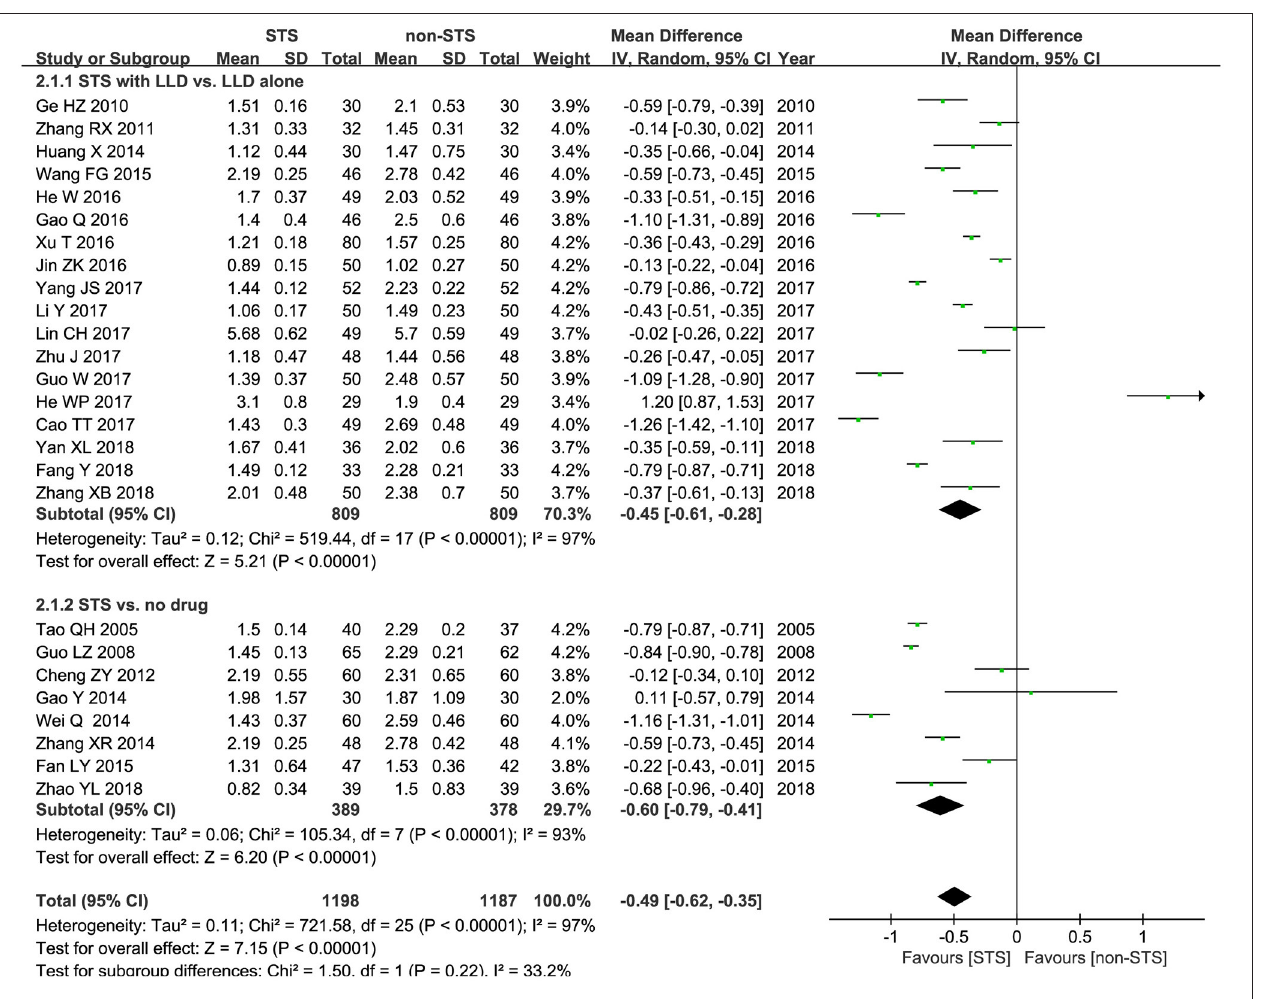
to LLDs [MD = − 0.45 mmol/l, 95% CI ( − 0.61, − 0.28), P < 0.00001, I 2 =